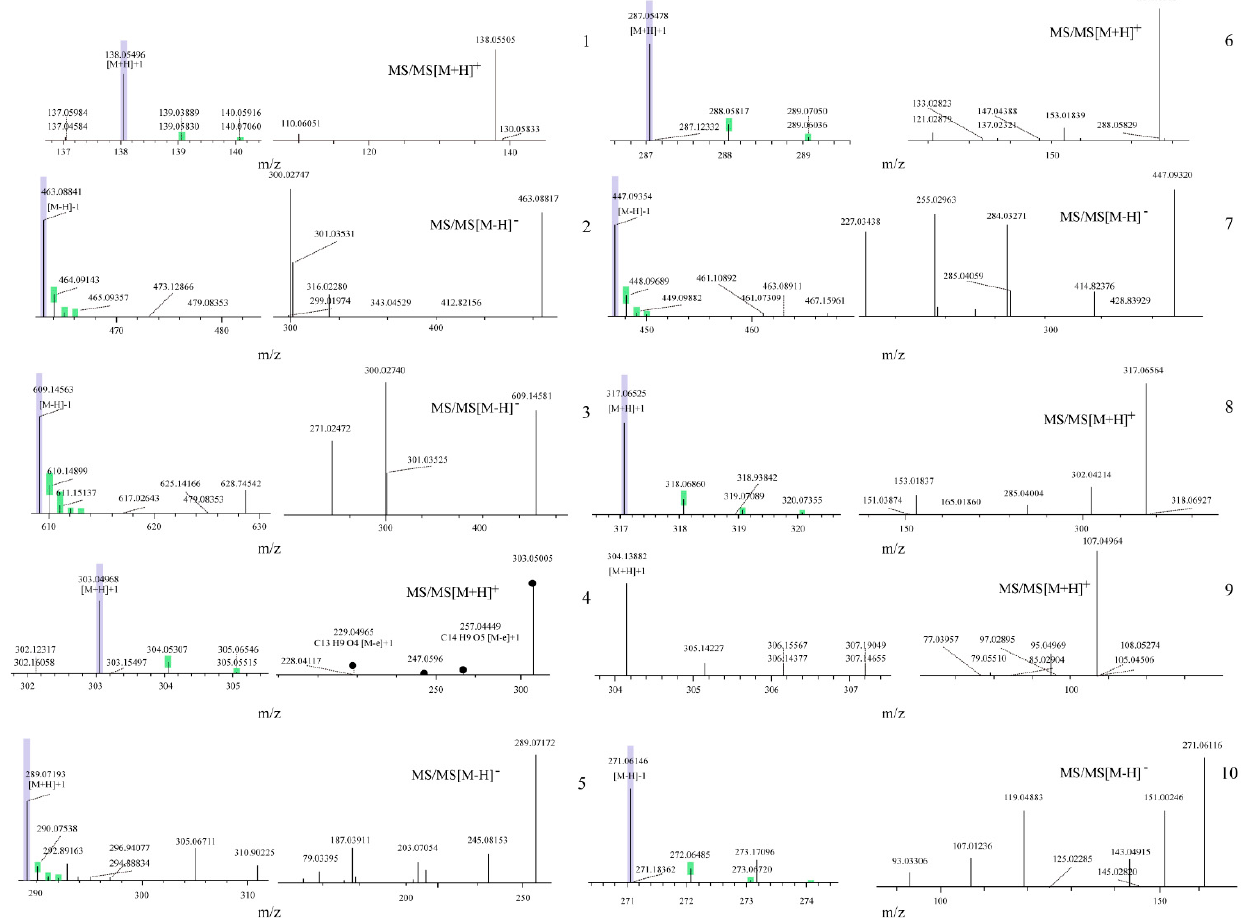
Figure 3. MS and MS/MS spectra profiles of 10 constituents in TFW measured by LC-MS.